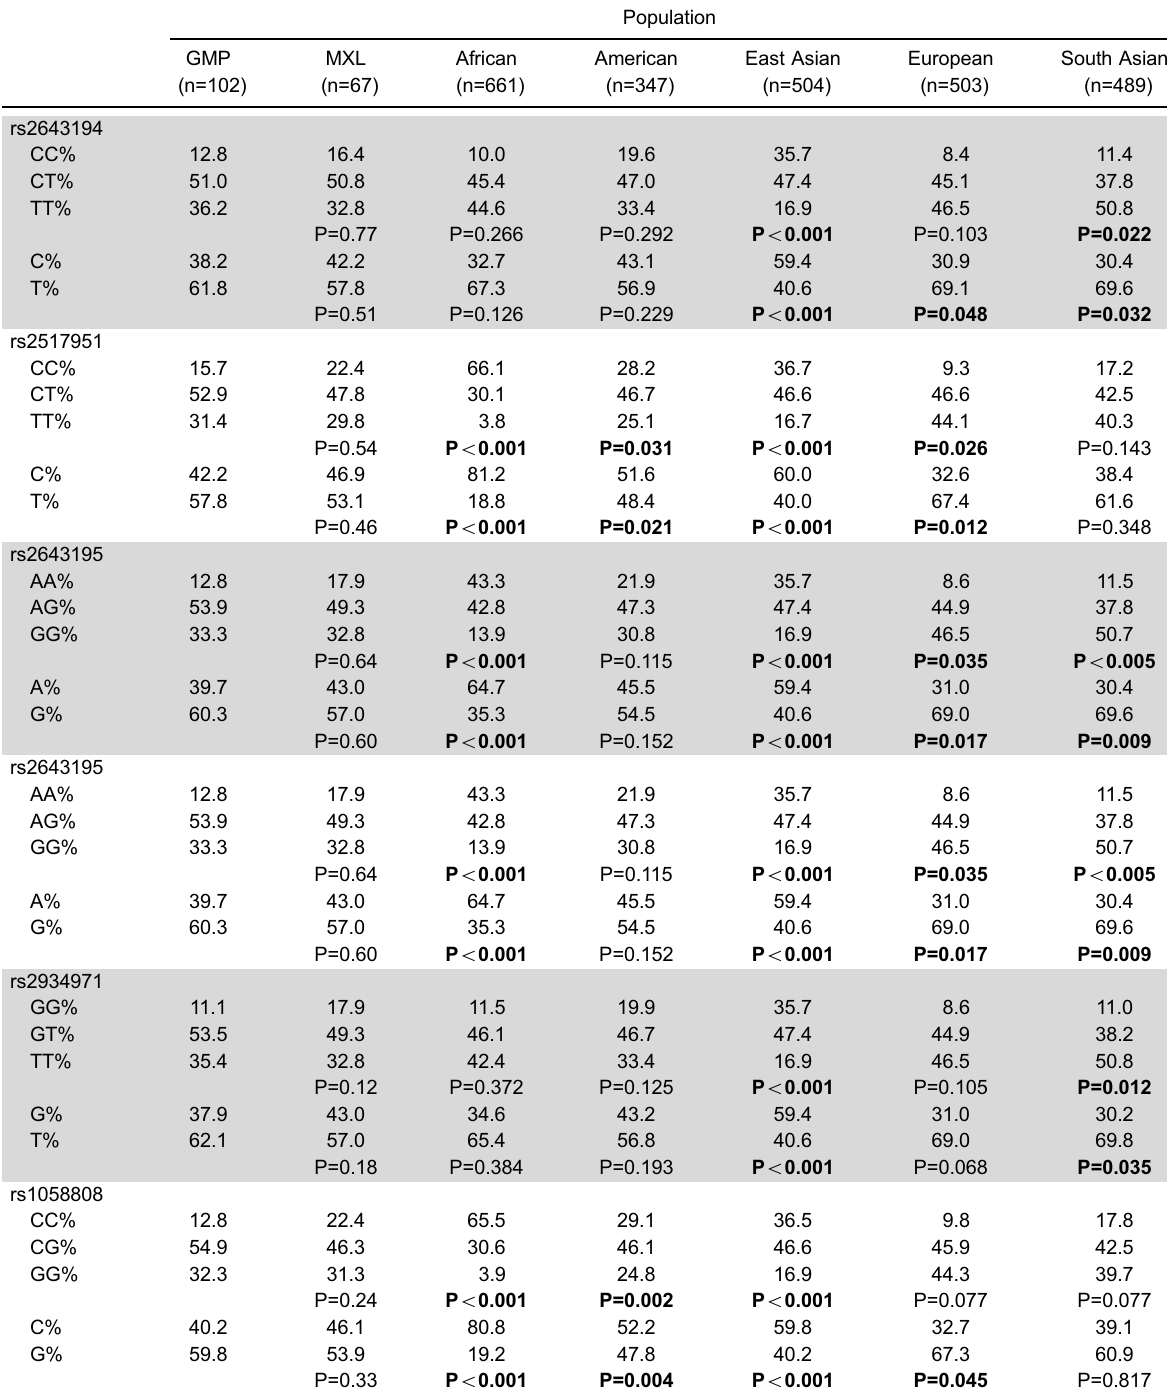
Table 3. Frequencies of the fi ve single nucleotide polymorphisms reported in several populations